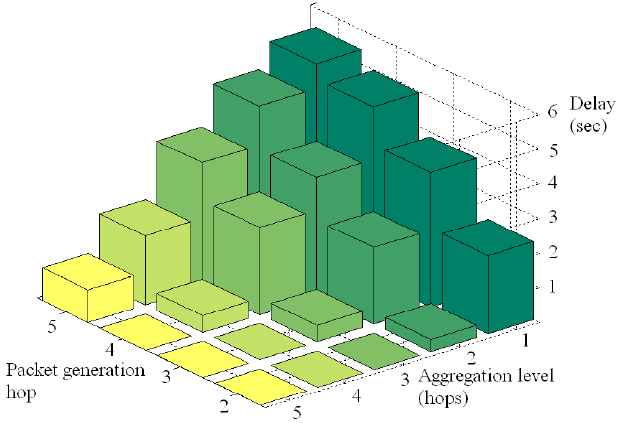
Figure 14. Observed delay for different aggregation levels and observation